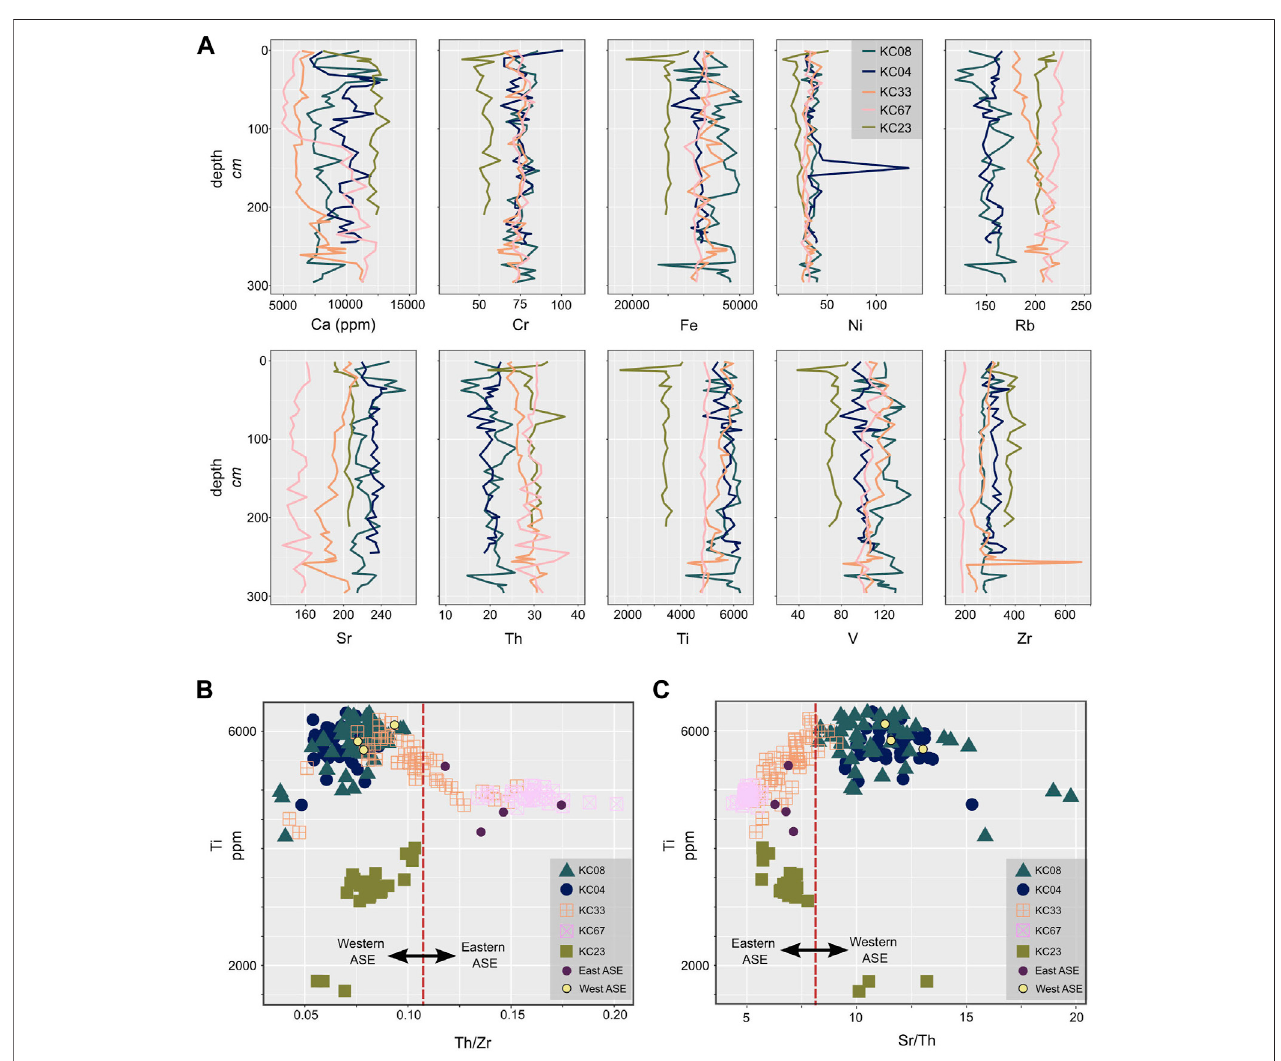
FIGURE 4 | Sediment core geochemistry. (A) Downcore concentrations ofselected trace elements in ppm. Core legend isgiven in the upper-rightcorner of the Ni plot. (B, C) Immobile trace elemental ratios Th/Zr and Sr/Th plotted against Ti. Element ratios of surface sediment samples ( < 63 microns) representative for the detrital input into the eastern Amundsen Sea Embayment (ASE, sites 30 – 33 of Simões Pereira et al., 2018) and the western ASE (sites 34, 36, and 38 of Simões Pereira et al., 2018) in the vicinity of Thwaites Glacier are shown for reference. The vertical dashed line indicates a division between eastern and western geochemical signals.